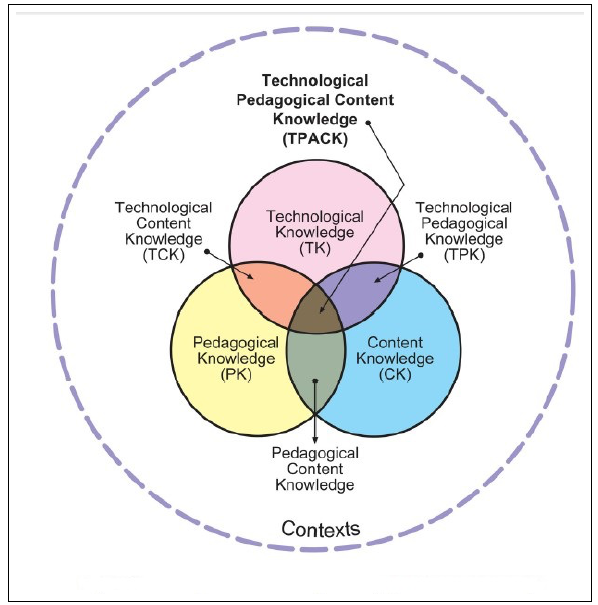
Figure 4. The TPACK framework, following [29] (2009, p.